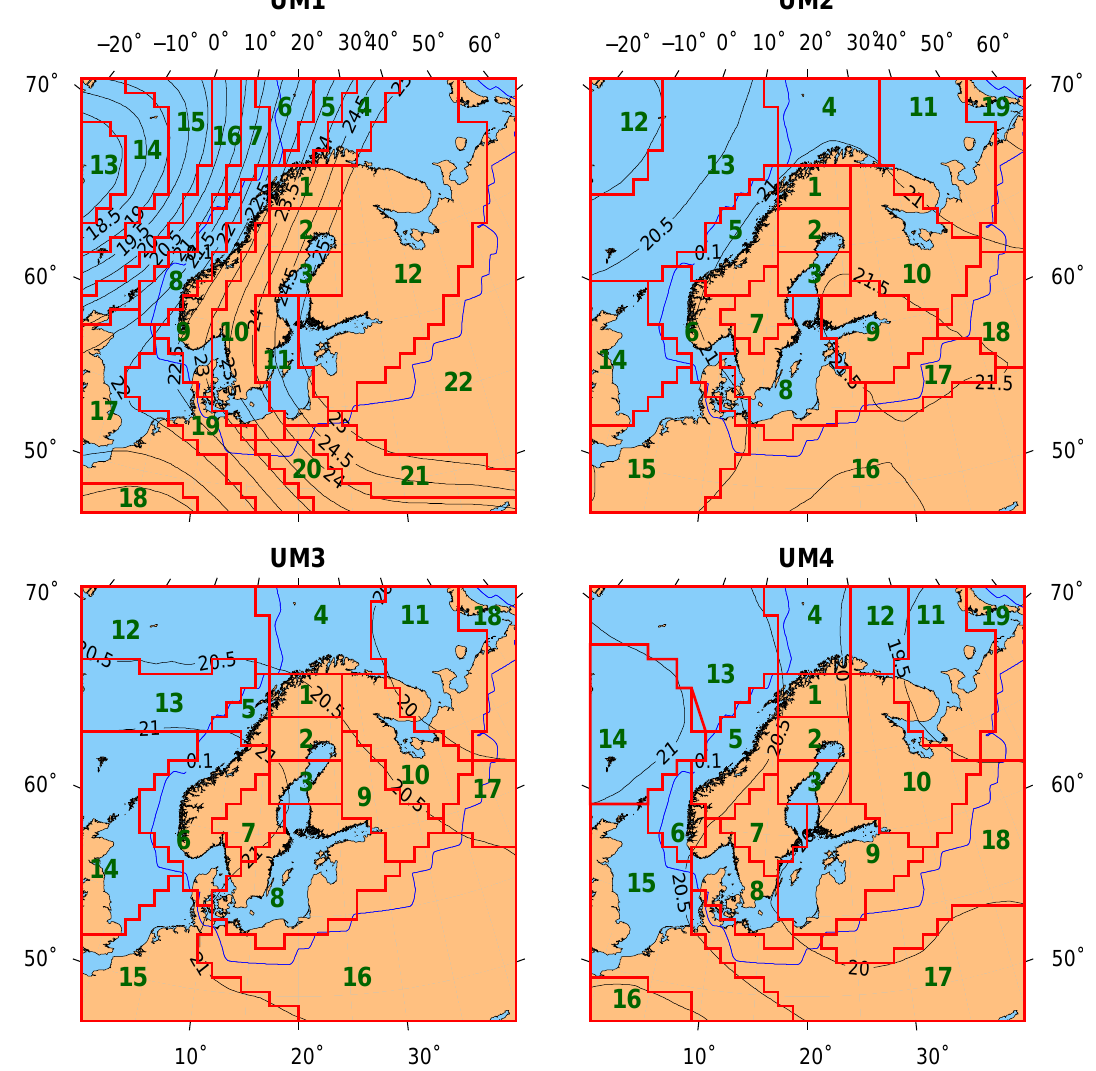
Figure 2. Distribution of viscosity blocks (red lines, green numbers) based on the lateral viscosity structure (black lines) as calculated from seismic tomography model S20A (Ekström and Dziewonski, 1998). Viscosity blocks are additionally subdivided into blocks inside and outside the former glaciated area (blue line, based on ice model FBKS8; Lambeck et al., 1998). Depth ranges: UM1 70 – 250 km, UM2